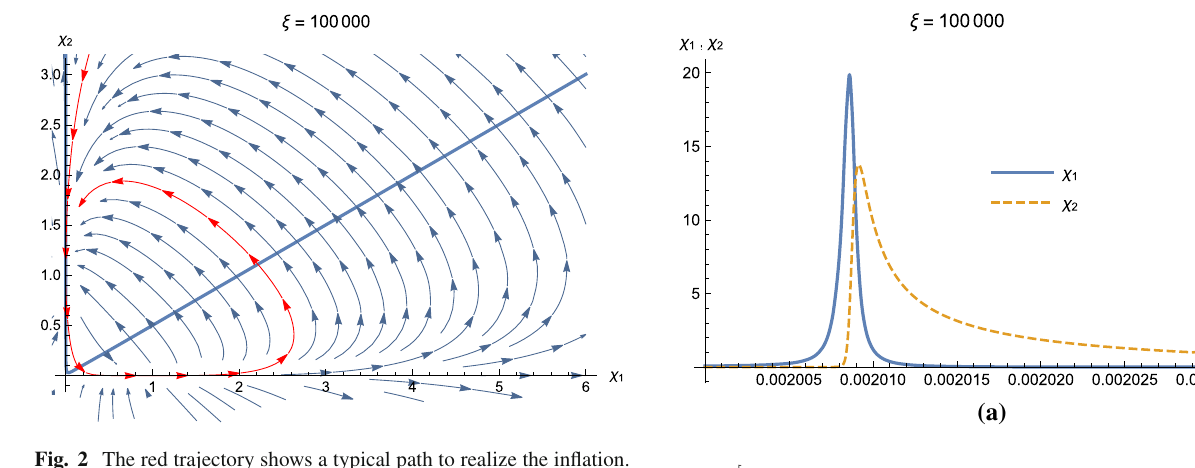
Fig. 2 The red trajectory shows a typical path to realize the inflation. One may interpret the semi-spiral trajectories as oscillations around the potential minimum. In the absence of matter and (p)reheating after the inflation, the simulation deviates from the standard early universe models but mathematically, one observes phantom crossings during the oscillatory phase